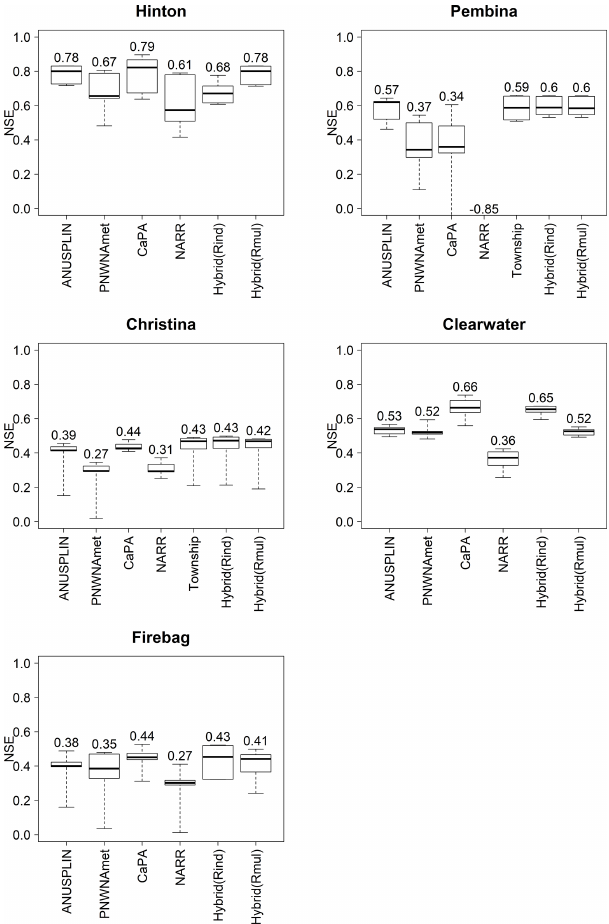
Figure 11. Boxplots of the NSEs of the proxy validation at the five sub-basins in the ARB. The values above each boxplot represent the average over NSEs of the proxy